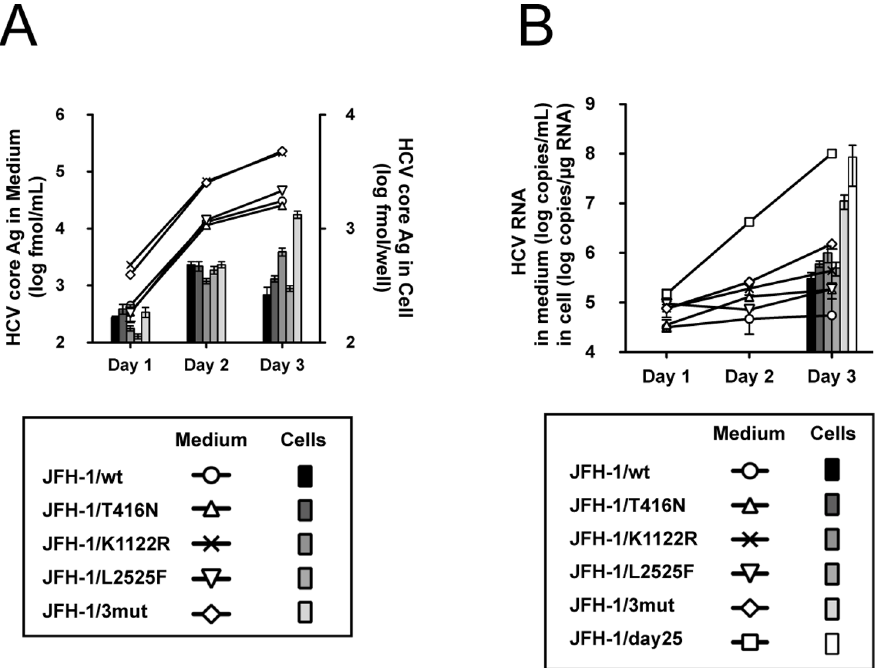
Figure 2. Effects of cell culture-adapted mutations on virus propagation. (A) One million cells were transfected with 2 m g of in vitro - transcribed RNA from JFH-1/wt, JFH-1/T416N, JFH-1/K1122R, JFH-1/L2525F and JFH-1/3mut. HCV propagation was monitored by measuring HCV core Ag. (B) The same amounts of JFH-1/wt, JFH-1/T416N, JFH-1/K1122R, JFH-1/L2525F, JFH-1/3mut and JFH-1/day25 viruses were used for infection of naı¨ve Huh-7.5.1 cells (MOI =1.0), and HCV RNA titers were subsequently monitored.